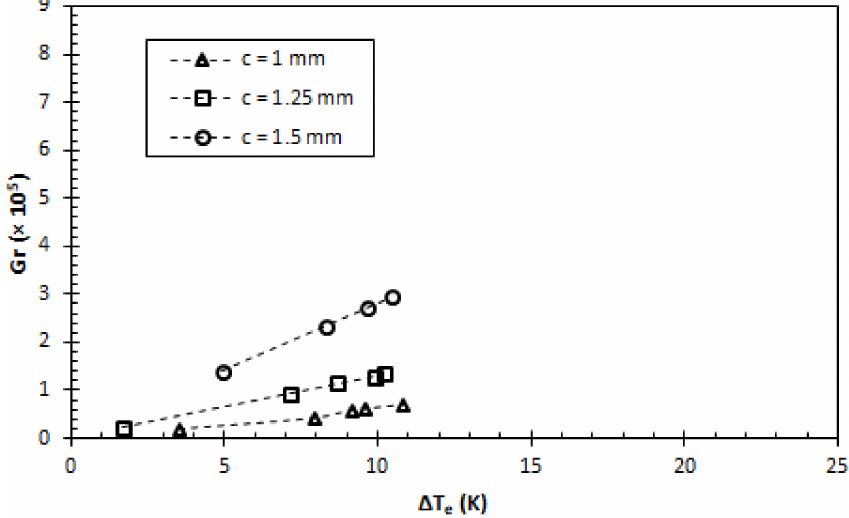
Figure 14. The plot of Grashof number from different rectangular pin fin